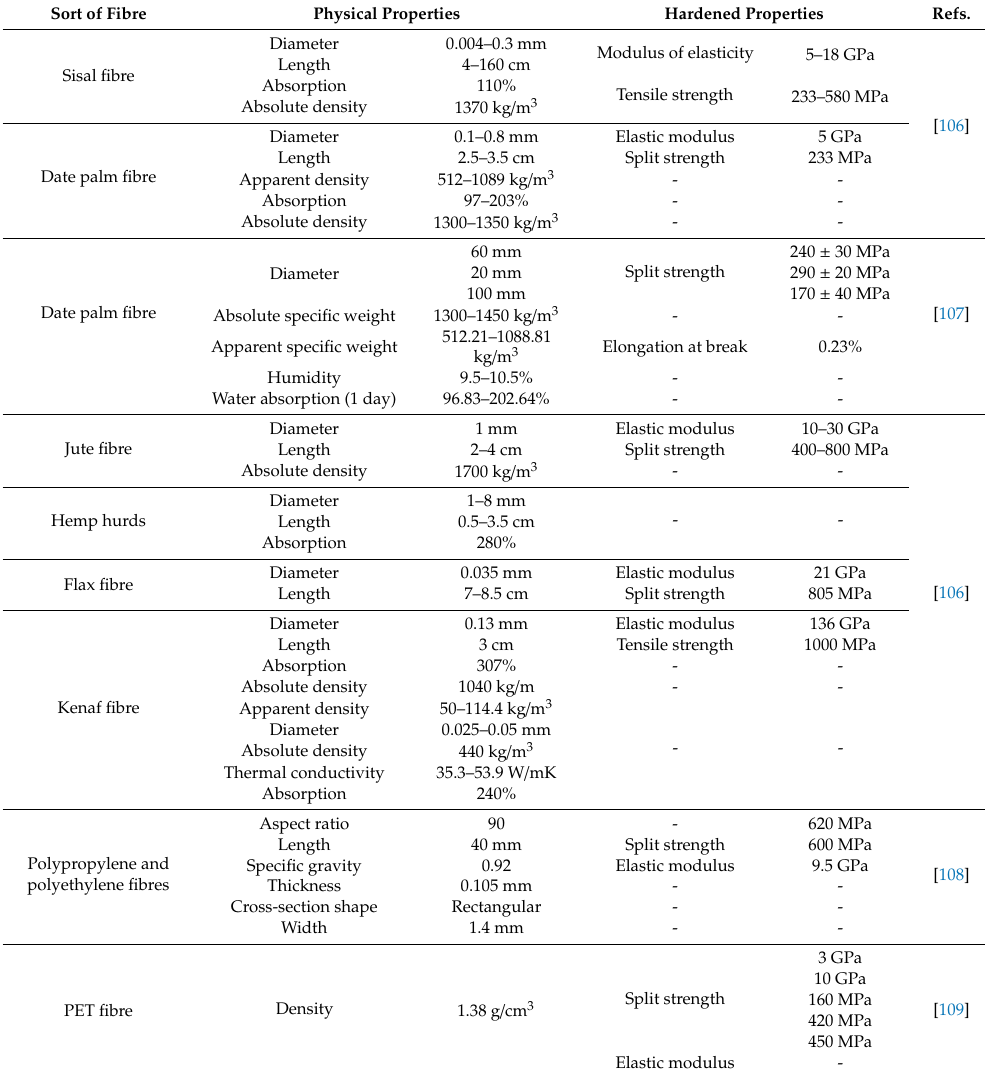
Table 5. Hardened and physical properties of some fibres used in